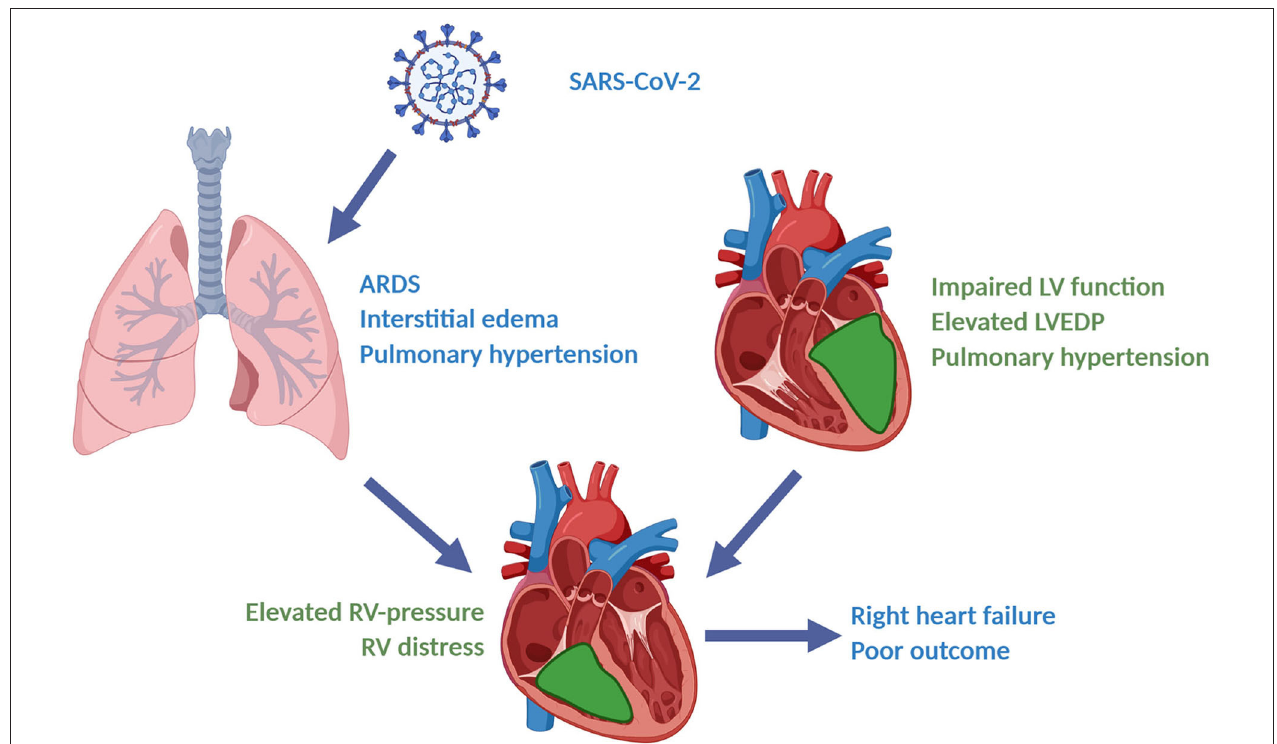
FIGURE 5 | Right heart failure caused by COVID-19-induced severe ARDS and preexisting left heart failure: A hypothesis. (Figure created with BioRender ®